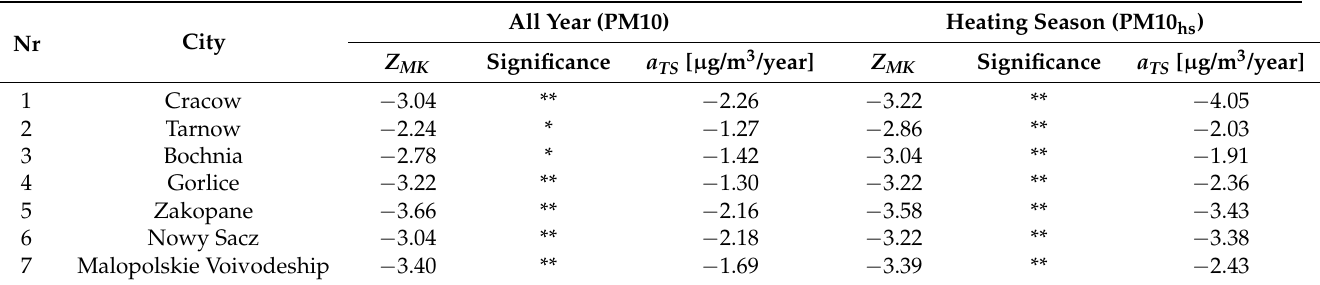
Table 3. Trends in average annual concentrations of PM10 and PM10 hs (heating season) in 2011–2020 obtained using the Mann–Kendall (MK) test and the Theil–Sen slope estimator.